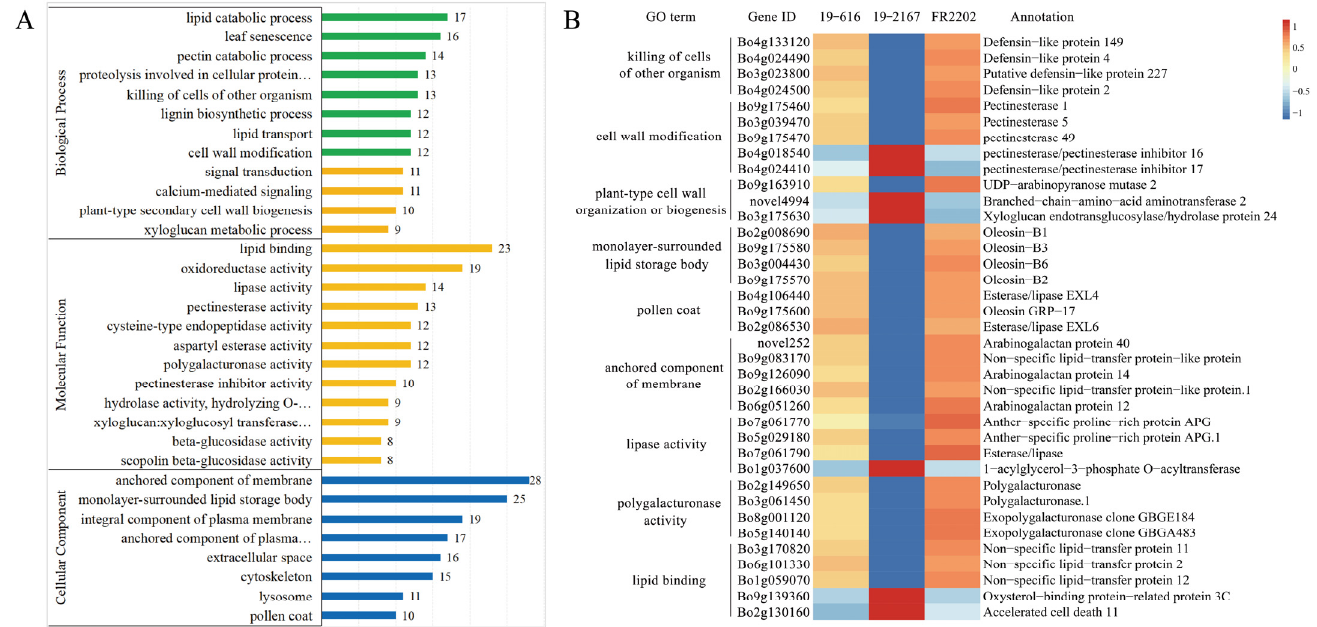
Figure 4. Gene ontology analysis of the core DEGs enriched in part Ⅳ . ( A ) The number of DEGs enriched in the three categories. ( B ) The expression trends and annotations of the core DEGs.